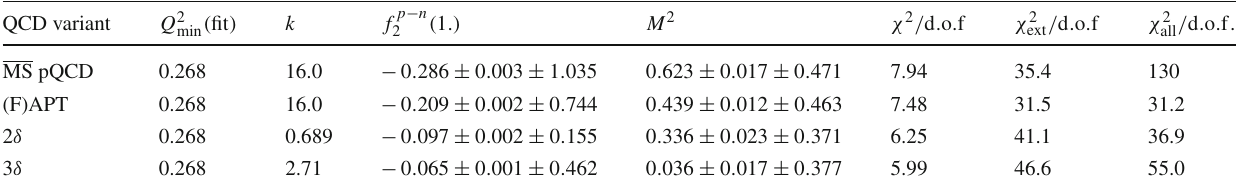
( fit ) = 0 . 268 GeV 2 . The extracted values min